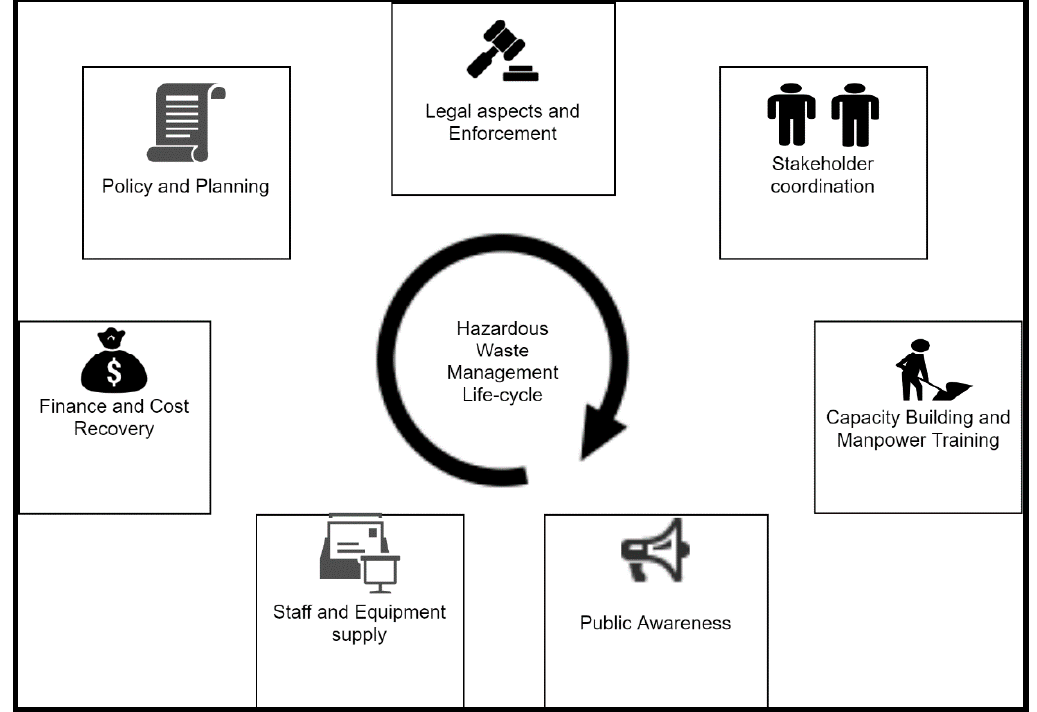
Figure 9. Hazardous Waste Lifecycle. Source: [67,87,88].